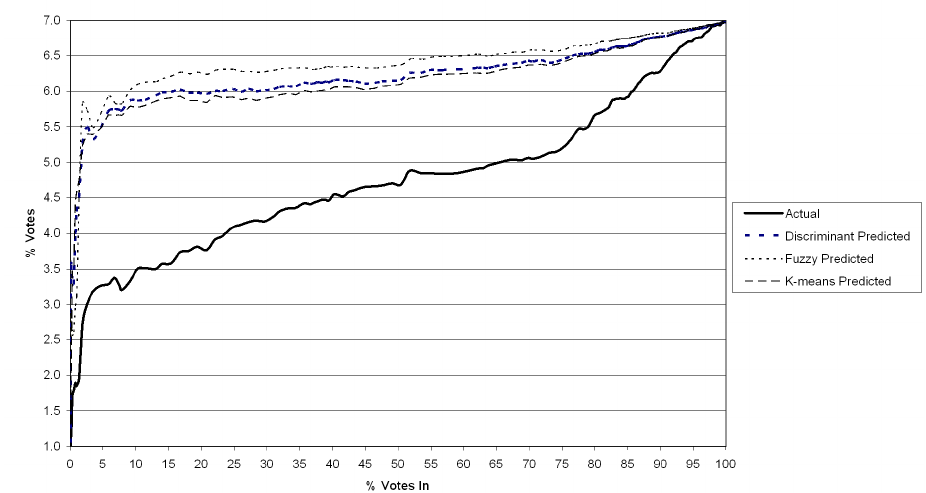
Figure 3: IFP results for the national elections in 2004 and their predictions as a function of the number of votes counted.